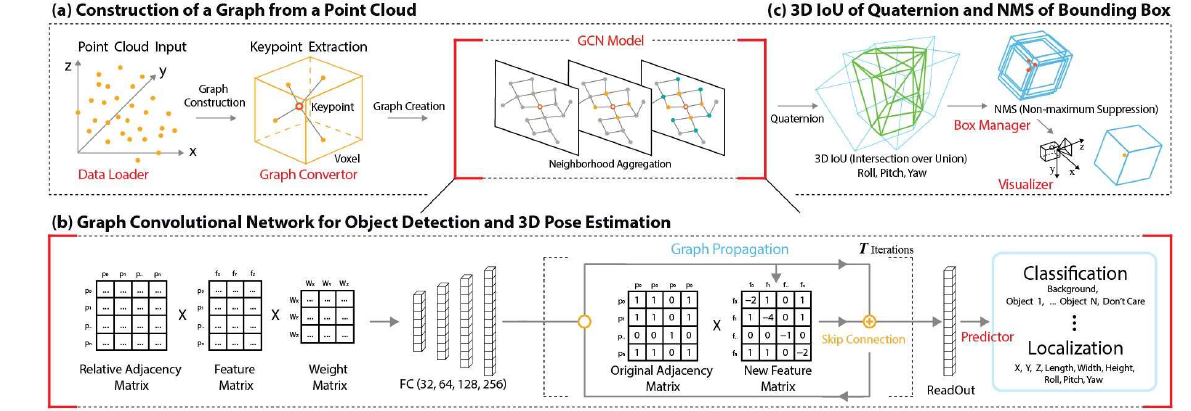
Figure 1. Proposed method with three components.